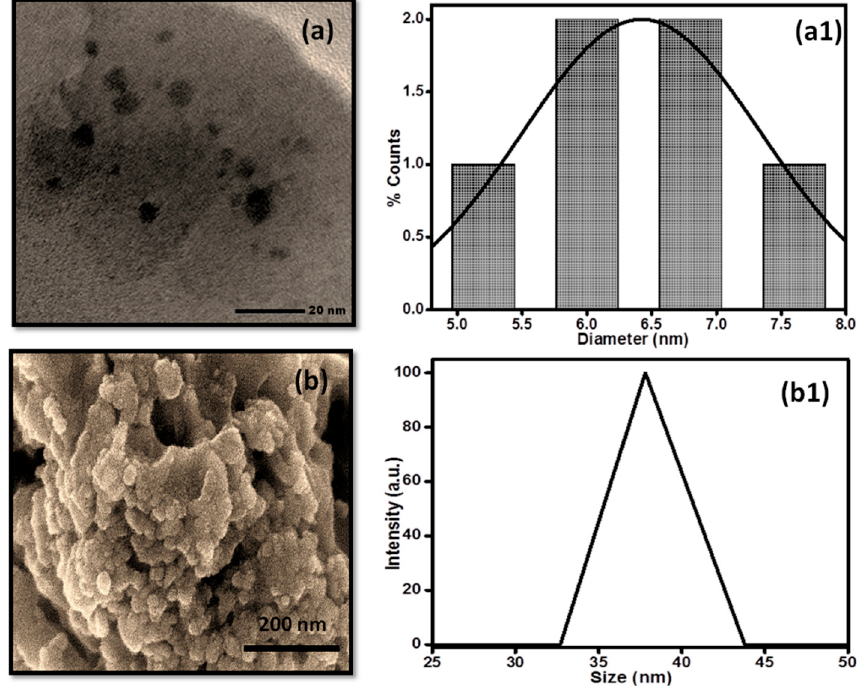
Figure 1. Typical XRD pattern of as-synthesized MPTMS@Gd 2 O 3 nanoparticles.